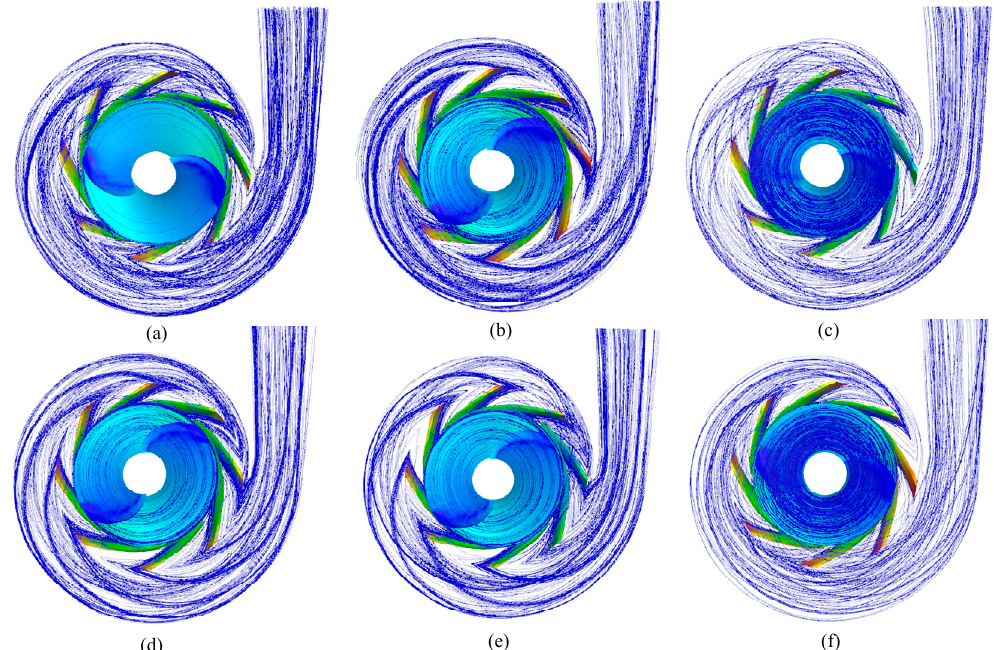
Figure 11. Comparisons of the pathlines between the combination impeller and the conventional impeller: ( a ) combination impeller, 0.8 Q d ; ( b ) combination impeller, 1.0 Q d ; ( c ) combination impeller, 1.2 Q d ; ( d ) conventional impeller, 0.8 Q d ; ( e ) conventional impeller, 1.0 Q d ; ( f ) conventional impeller, 1.2 Q d .